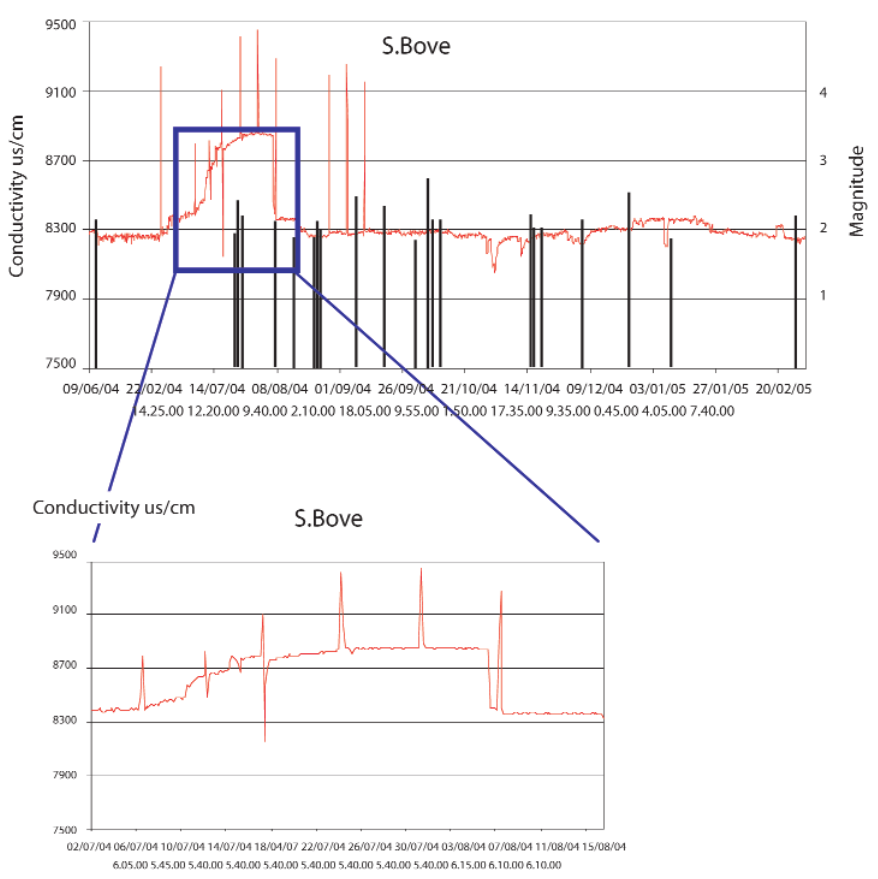
Fig. 12. Temporal variations in conductivity at the Bove spring during June 2004-February 2005 observative interval. The earthquakes occurred within a 20km-radius area centered on Porretta Terme town are shown as ver- tical black lines. Only the July 2004 shocks caused temporary modifications in the electrical conductivity. The recorded spikes are a consequence of the «anthropic disturbances» due to chlorine addition to the